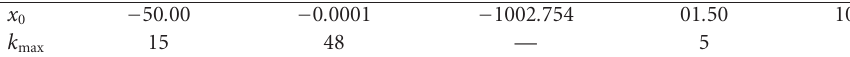
Table 5.1. Newton